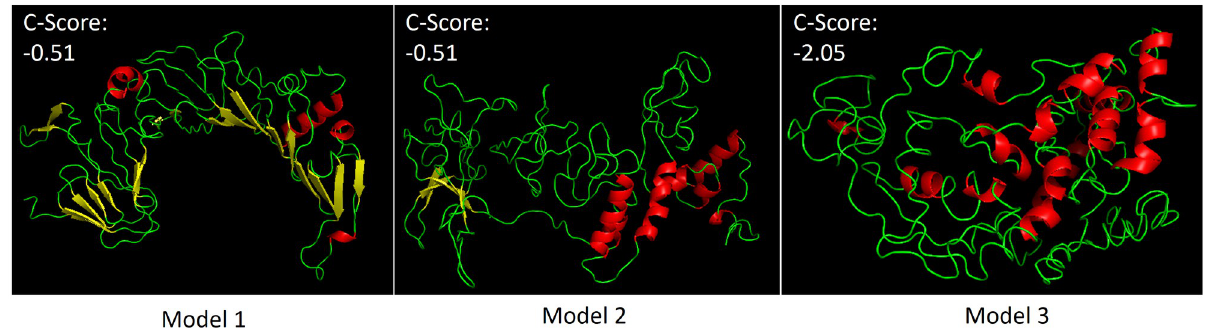
Fig 6. I-TASSER software prediction of secondary and tertiary structure. Top three 3D conformation models predicted by I–TASSER, with predicted c-Score shown on each model. Alpha-helices are shown in red, beta-strands in yellow, and loops shown in green. The structure was obtained from the protein data bank (PDB) files produced by I-TASSER and viewed with PyMOL Molecular Graphics System (2.5.2 Edu), Schro¨dinger, LLC.